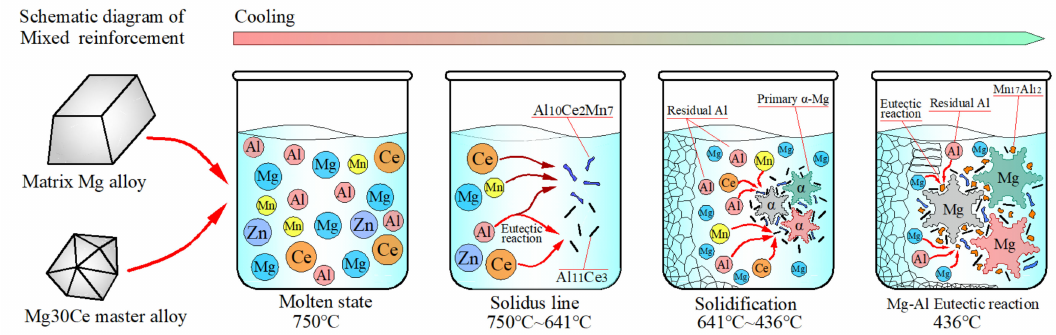
Figure 13. The strengthening mechanism of Ce element in the solidification process of Mg-Al